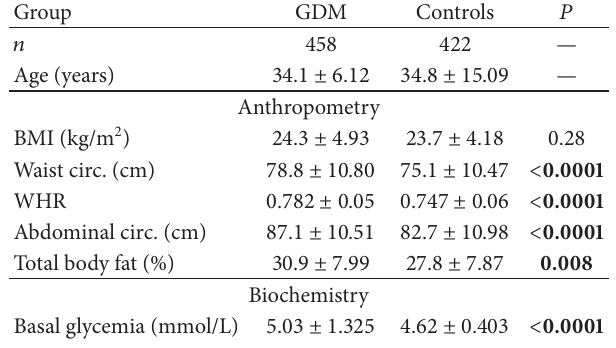
Table 1: Subject